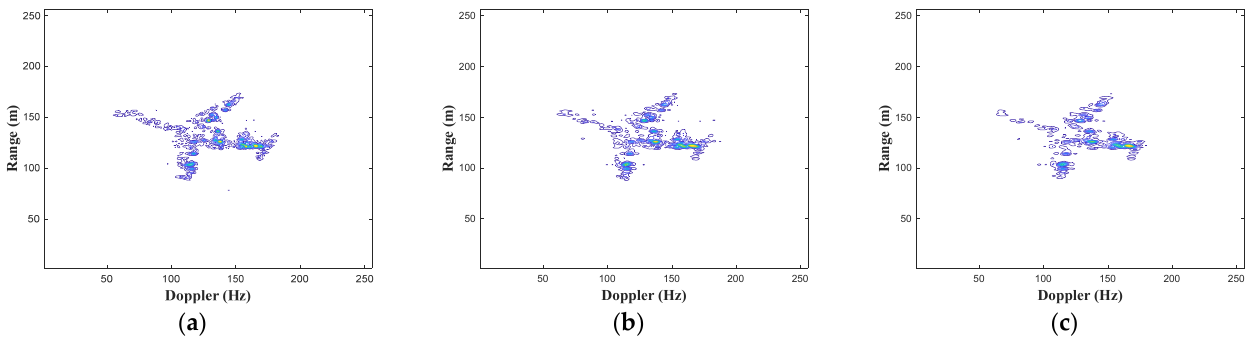
Figure 12. The recovered image using the KF ‐ tracking method. ( a ) 128 pulses. ( b ) 64 pulses. ( c ) 32 pulses.